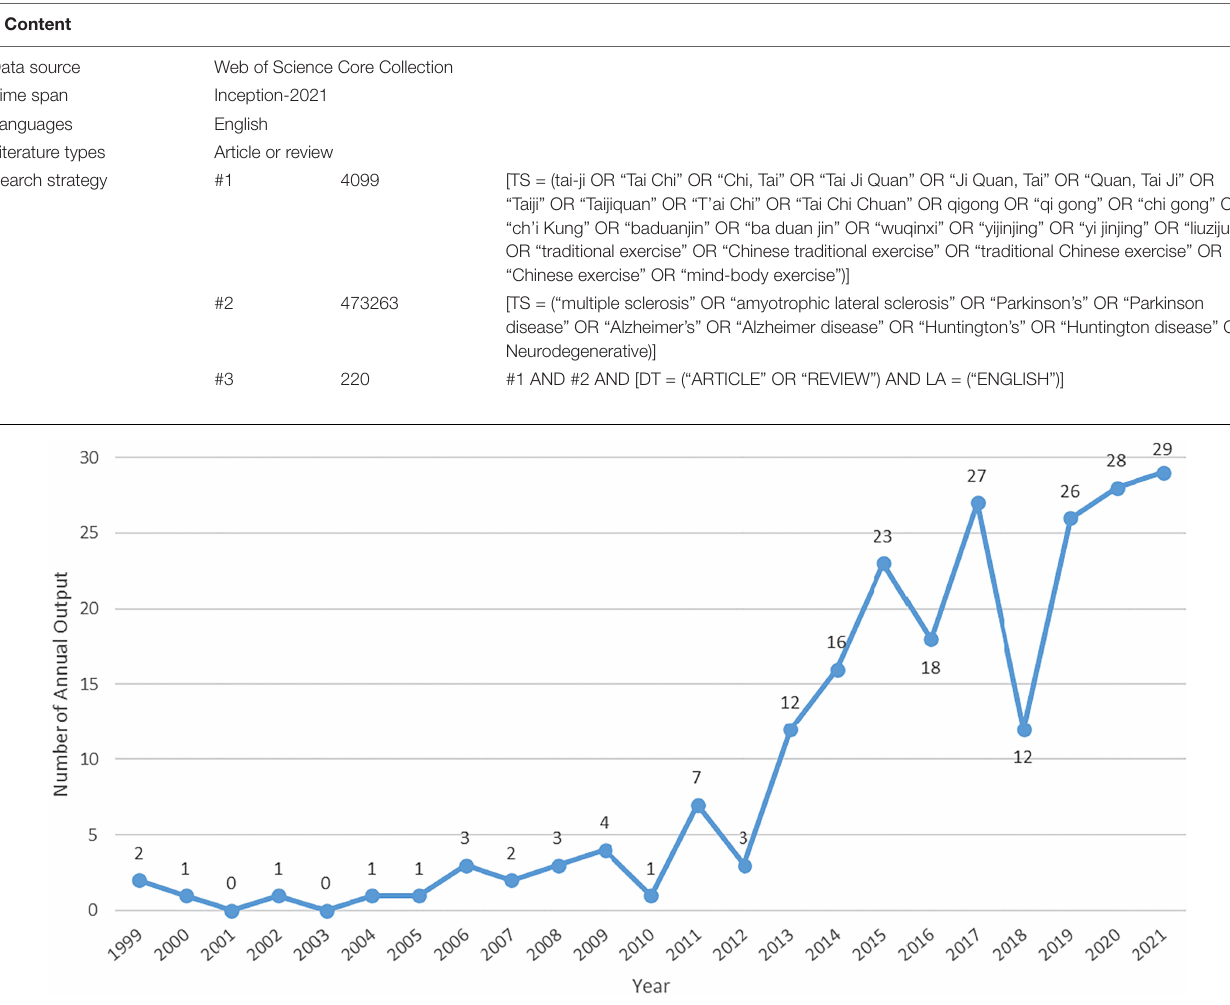
TABLE 1 | Summary of literature selection in this study.